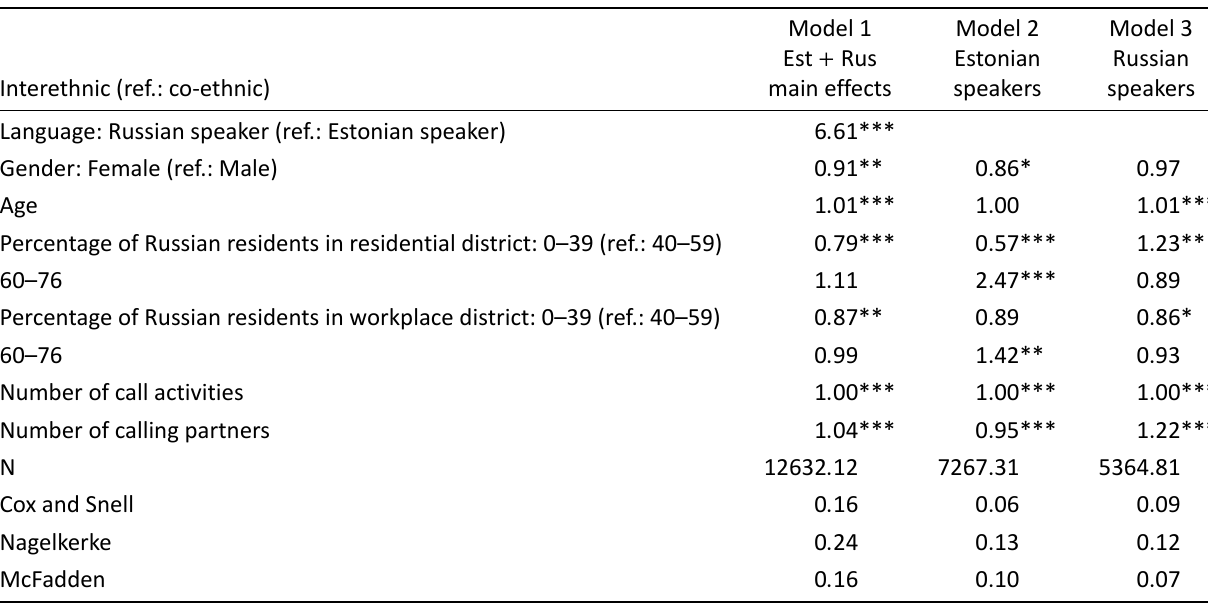
Table 2. The personal socio-demographic characteristics, the ethno-linguistic composition of place of residence and work- place, and the size of social network relationship with the existence of an interethnic